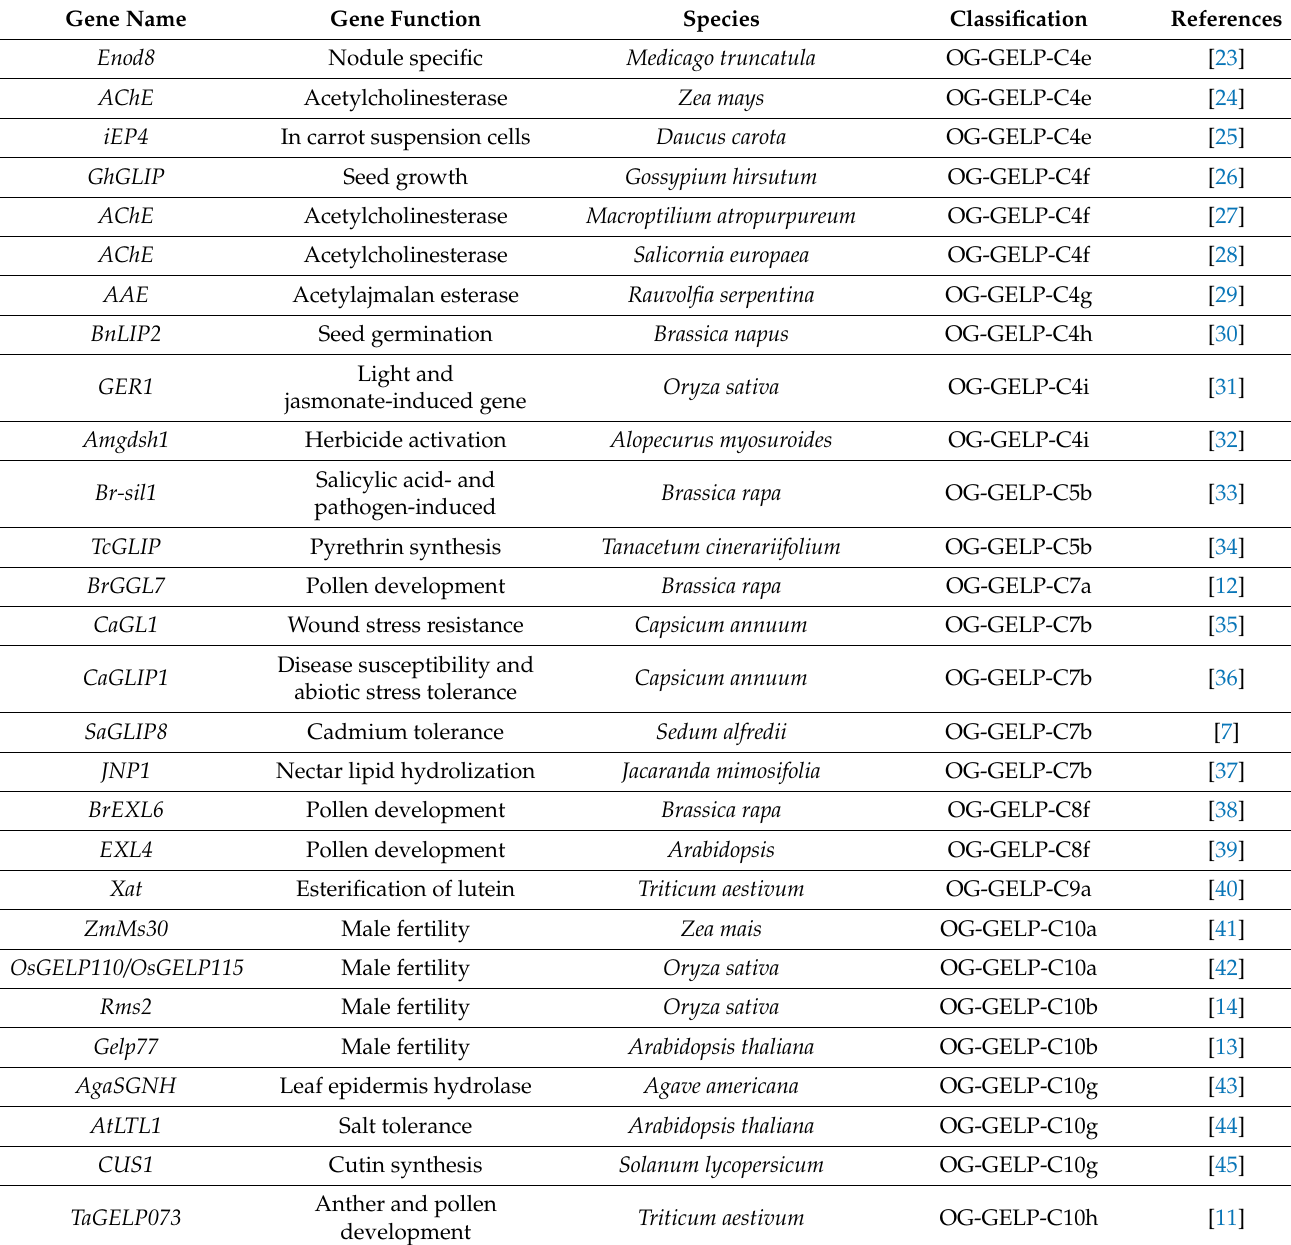
Table 4. Classification of published GELP genes with functional characterization. The protein sequences of species not sampled for the establishment of OG are in Supplementary Data